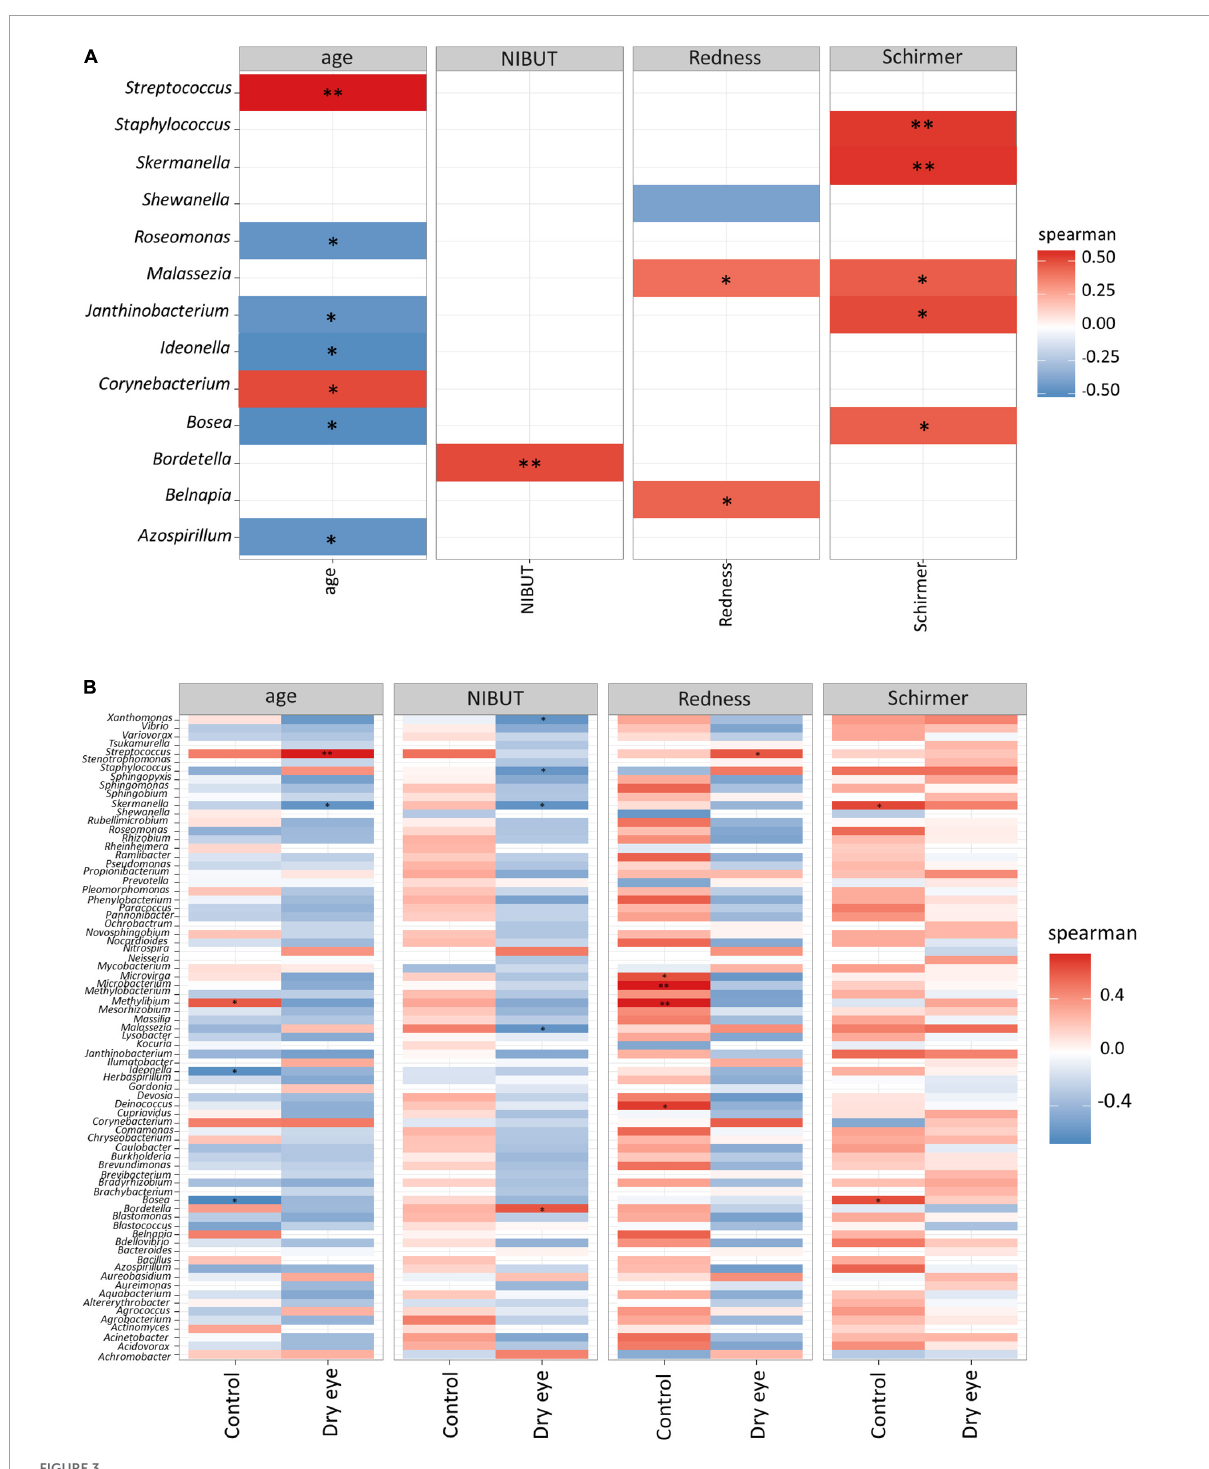
FIGURE3 Correlation between microbial genera and demographic/clinical parameters. Each horizontal row indicates a unique microbial genus, and the horizontal axis indicates the correlation analysis with age, and three other clinical parameters. NIBUT: Non-invasive tear break up times (in seconds), redness: average temporal bulbar redness quantified automatically by Oculus Keratograph K5M; Schirmer: Schirmer I test results (mm over 5 min). The value of the Spearman correlation coefficient, which measures the strength and direction of association between two ranked variables, is color coded. Strong red color indicates positive correlation and strong blue color indicates negative or inverse correlation. Weak or faint color indicates weak or no correlation. (A) All participants included in analysis, and (B) Correlation stratified according to dry eye status (with or without dry eye). ∗ p < 0.05; ∗∗ p <